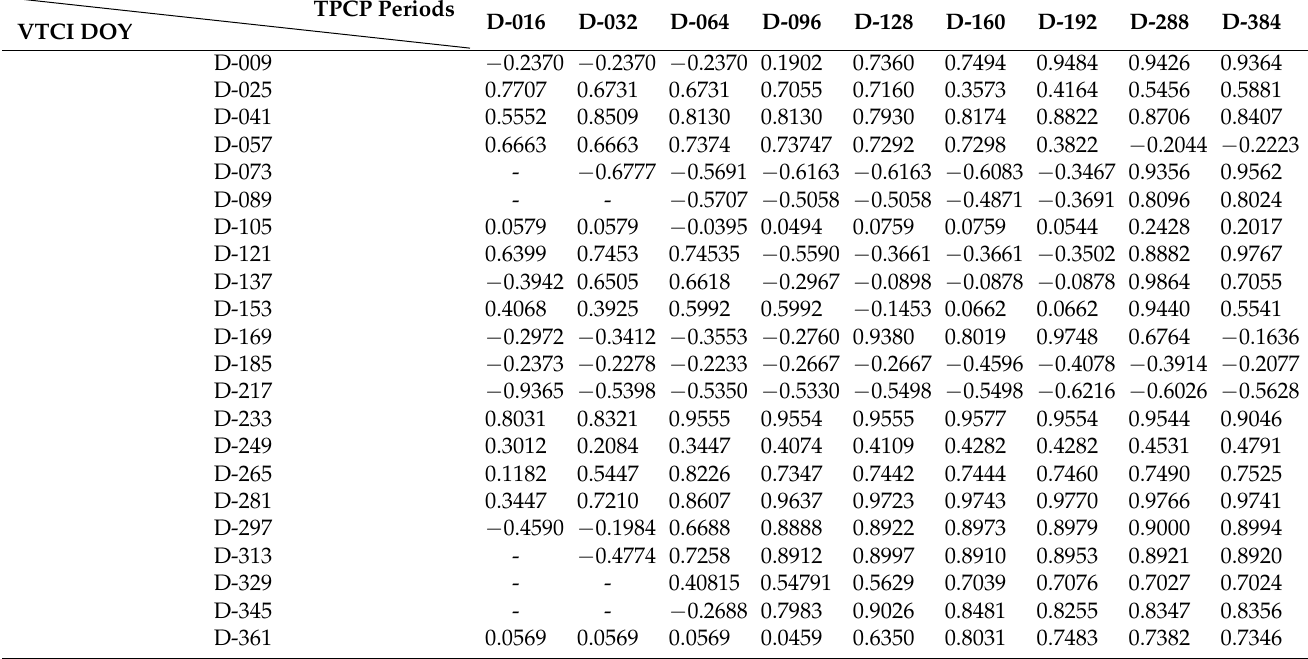
Table 3. Linear correlation coefficients between VTCI during 2010 and cumulative precipitation in the D-009 to D-361 during